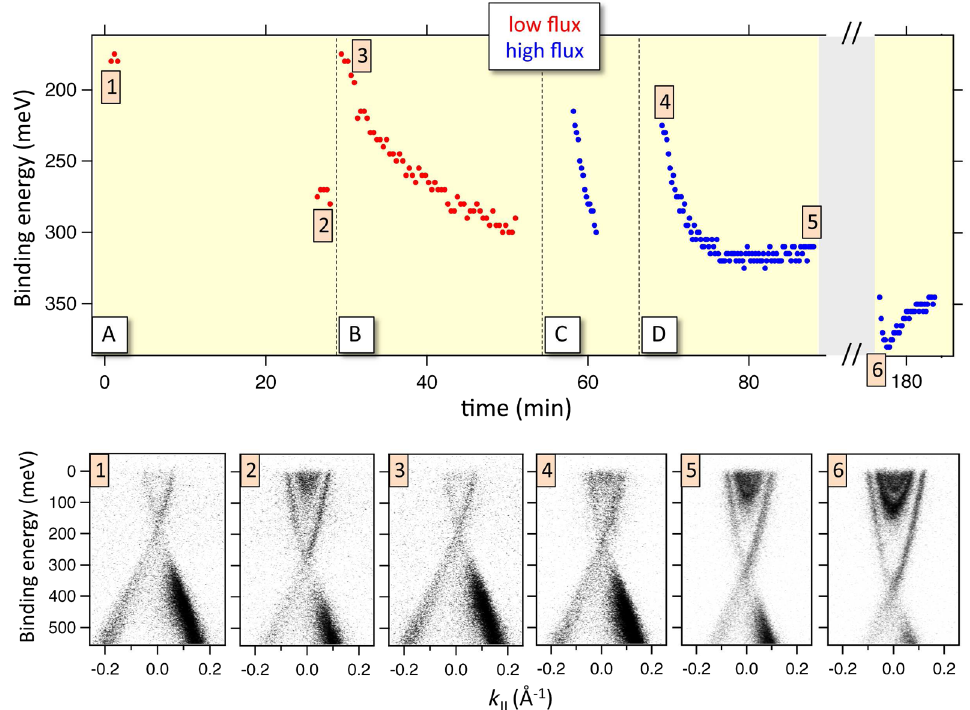
FIG. 4. The local character of EUV-induced surface band structure changes in 3D TIs, and the effect of photon flux. The upper panels show the evolution of E D in Bi 2 Se 3 on exposure of four different sample locations labeled A – D to low (red) and high (blue) photon flux. Vertical dashed lines denote the change of sample location. The lower panels show the I ð E; k Þ images corresponding to the numbered points (1 – 6) superimposed on the curves in the uppermost panels. The pressure during measurements was 1 . 5 × 10 − 10 mbar. The flux corresponding to the red data points was 3 – 4 times lower than the flux corresponding to the blue data points. All data have been acquired at 38 K using a photon energy of 30